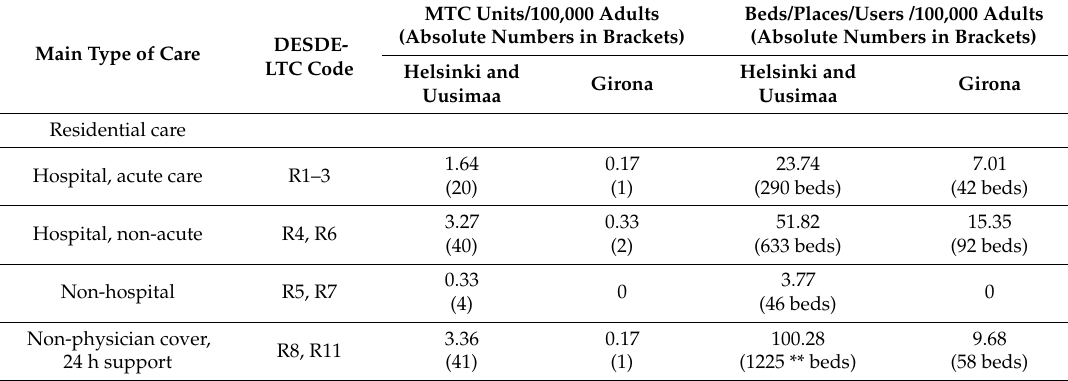
Table 2. The main type of care (MTC) units and capacity per 100,000 adults in residential care, day care, and outpatient service branches of the Description and Evaluation of Services and Directories in Europe for Long Term (DESDE-LTC) code